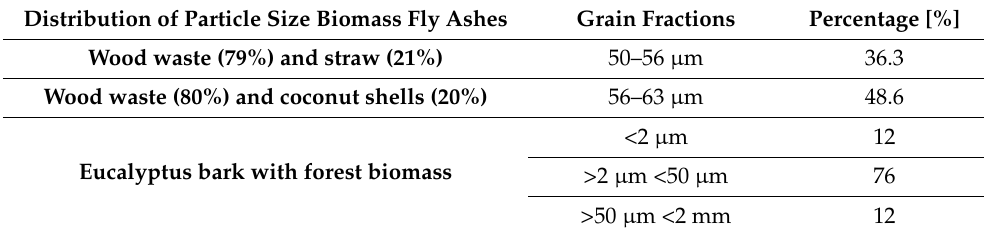
Table 5. Graining of fly ashes from the combustion of selected types of biomass. Distribution of Particle Size Biomass Fly Ashes Grain Fractions Percentage [%] Wood waste (79%) and straw